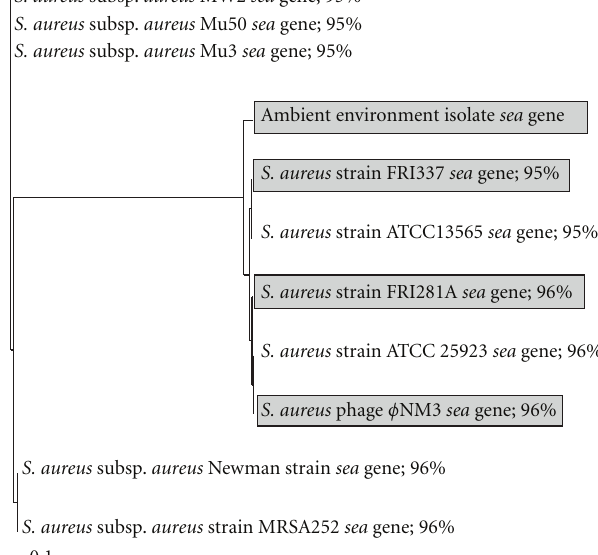
0.1 Figure 3: ClustalX2 guide tree of the top BLASTN hits of the sea gene from the ambient environmental isolate. The ambient air isolate is highlighted by a gray box along with S. aureus strains FRI337 and FRI281A (Food Research Institute) because the positive control used for sea exotoxin PCR comes from S. aureus strain FRI913. Percent identities are indicated beside the organism name as listed in GenBank. The GenBank Accession number for the sea -related gene is